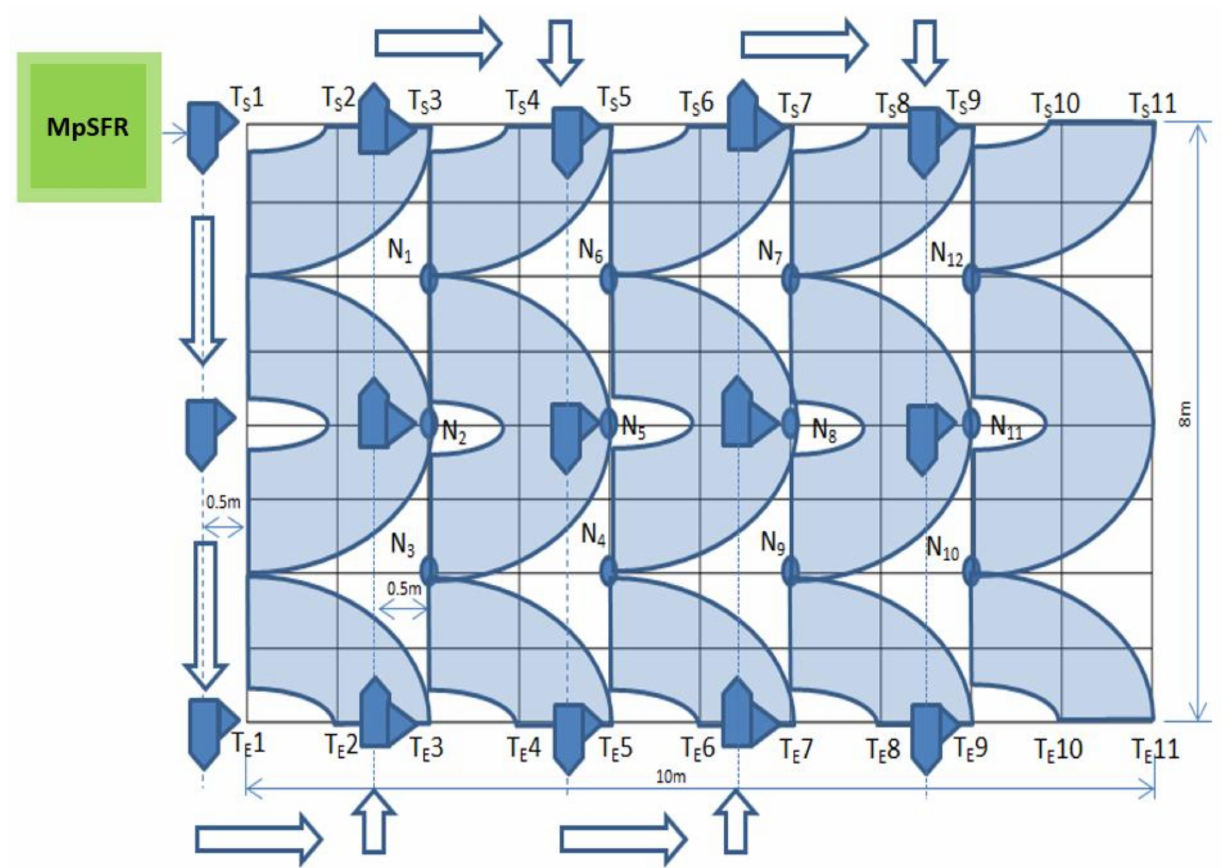
Figure 9. The pattern of smart irrigation in the considered Papaya test field (Note: T S 1, T S 2, etc. represents the starting position; T S 1, T S 2, etc. represents he end positions; N 1 , N 2 , etc. represents the